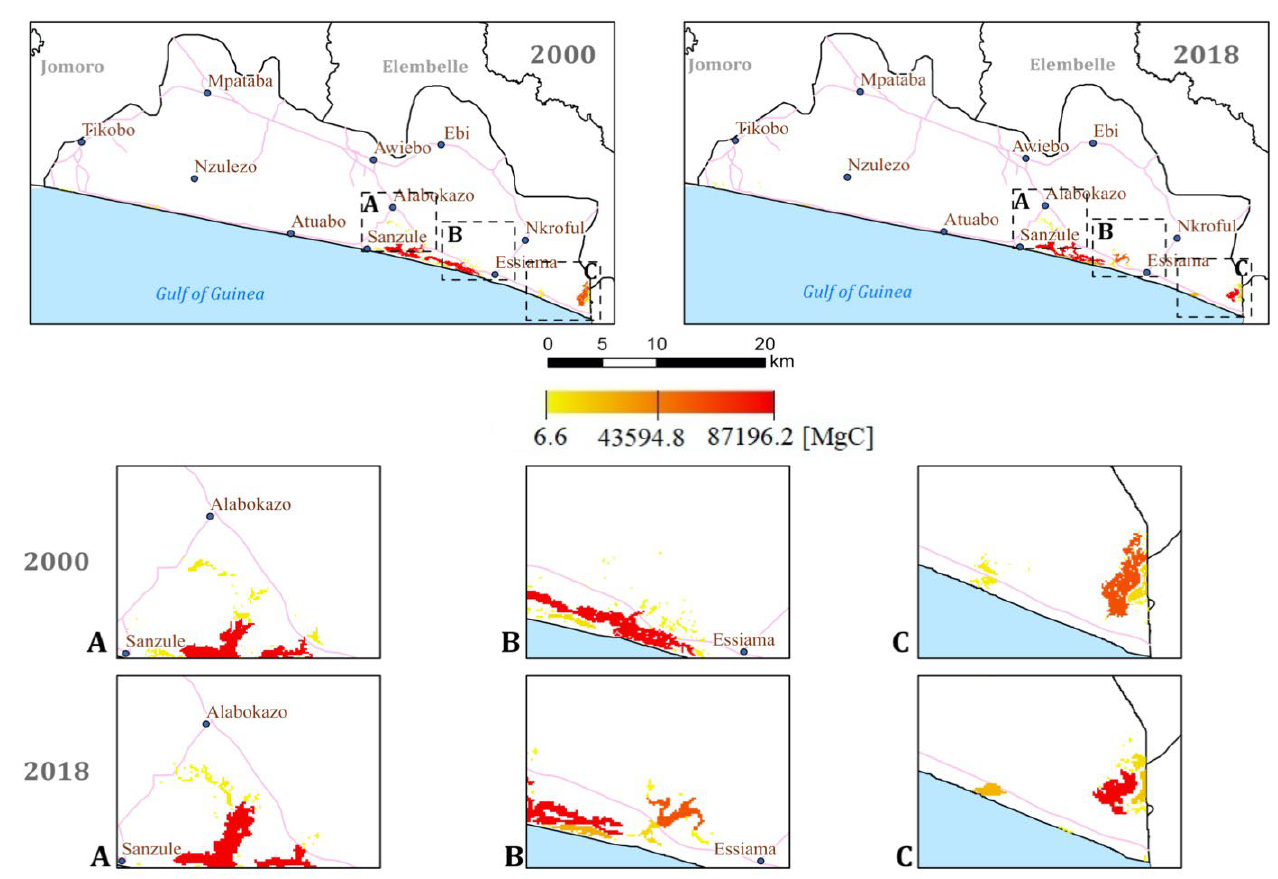
Figure 7. Quantities and distribution of aboveground carbon stored in mangrove forest across the landscape in 2000 and 2018; ( A – C ) compares the spatial and temporal distribution of aboveground carbon storage potential of sections of the landscape.